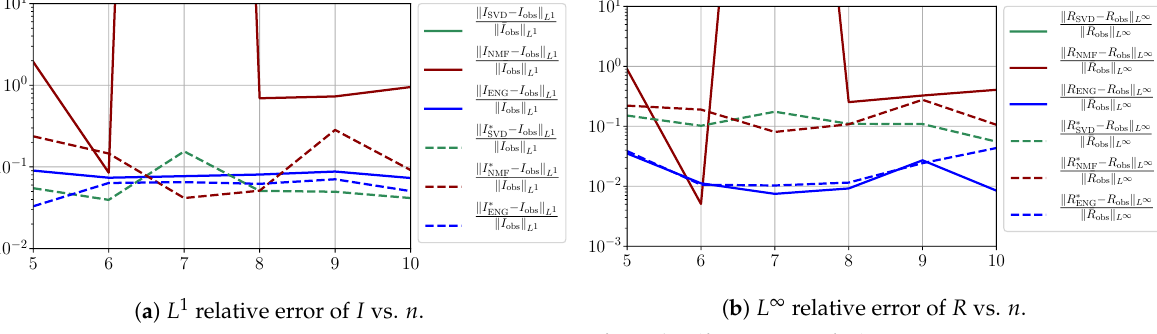
Figure A10. Forecasting errors of I and R (from T = 03/04).